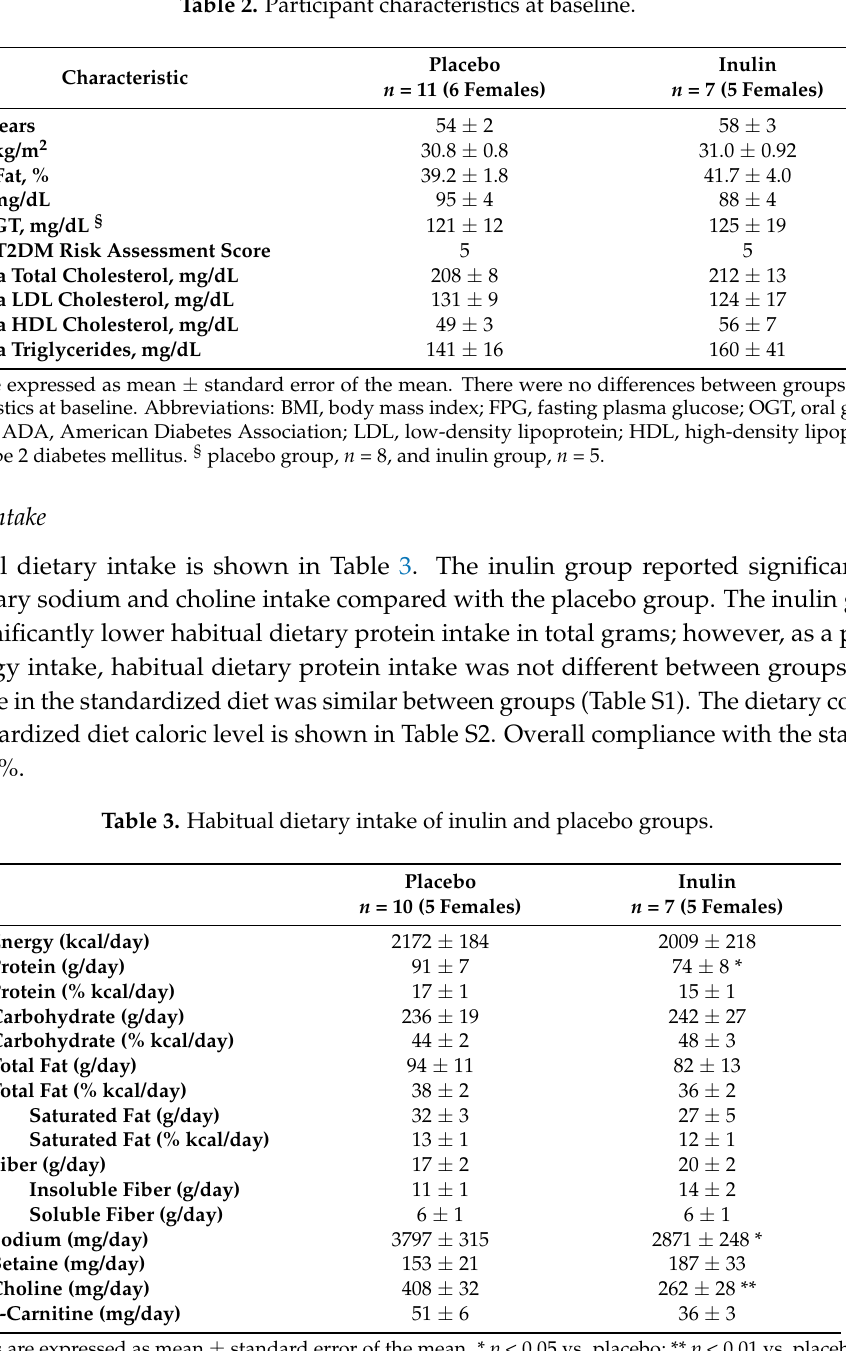
Table 2. Participant characteristics at baseline.